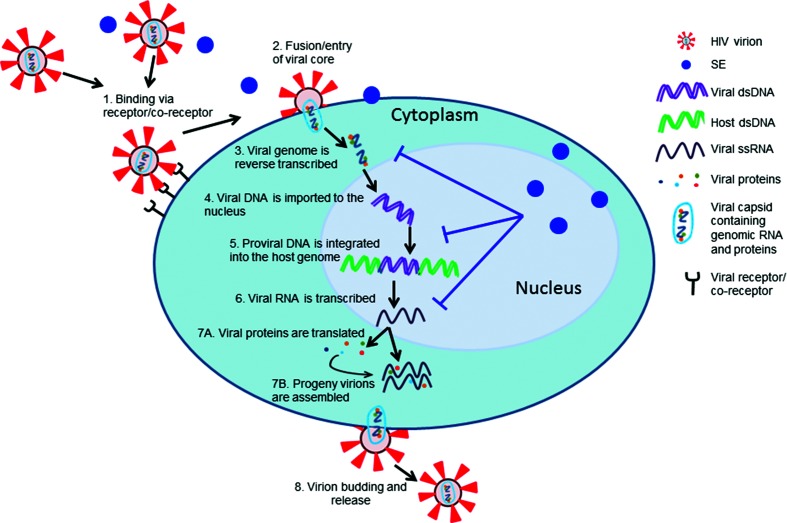
Semen exosomes inhibit HIV-1 lifecycle steps. Schematic of the HIV-1 lifecycle. (1) HIV-1 virions bind to cell receptor/co-receptor. (2) Fusion and entry inserts the viral core in the cell cytoplasm. (3) The viral genome is reverse transcribed from single-stranded RNA to double-stranded DNA. (4) Viral double-stranded DNA is imported into the cell nucleus. (5) Viral double-stranded DNA is integrated into host double-stranded DNA. (6) Viral RNA is transcribed from integrated DNA. Concurrently, (7A) viral proteins are translated from viral RNA and (7B) progeny virions are assembled with viral proteins and viral RNA. (8) New HIV-1 virions bud from the cell plasma membrane. Semen exosomes inhibit HIV-1 at the steps of reverse transcription, proviral integration and viral transcription. See text for references.